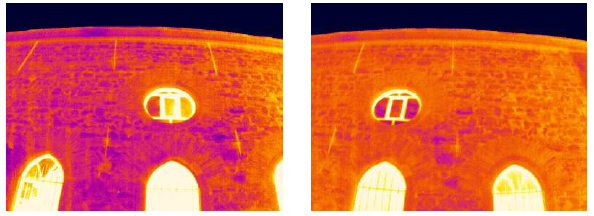
Figure 2a. Left image, 1b. Right image To overcome radiometric instabilities of the images, local histogram equalization called as adaptive histogram equalization were applied to the images. Before the implementation of the histogram equalization, color image representation were decomposed as Red Green and Blue channels in order to obtain more efficient equalization results. When the original histogram of the channels were inspected, Green and Blue channels were processed, Red channel was left intact due to their histogram distribution. Figure 3 and 4 show before/after histogram equalizations of the left and right images respectively. In this step, thermal images were provided more appropriate representation of the scene. Instable features of the thermal images were reduced.